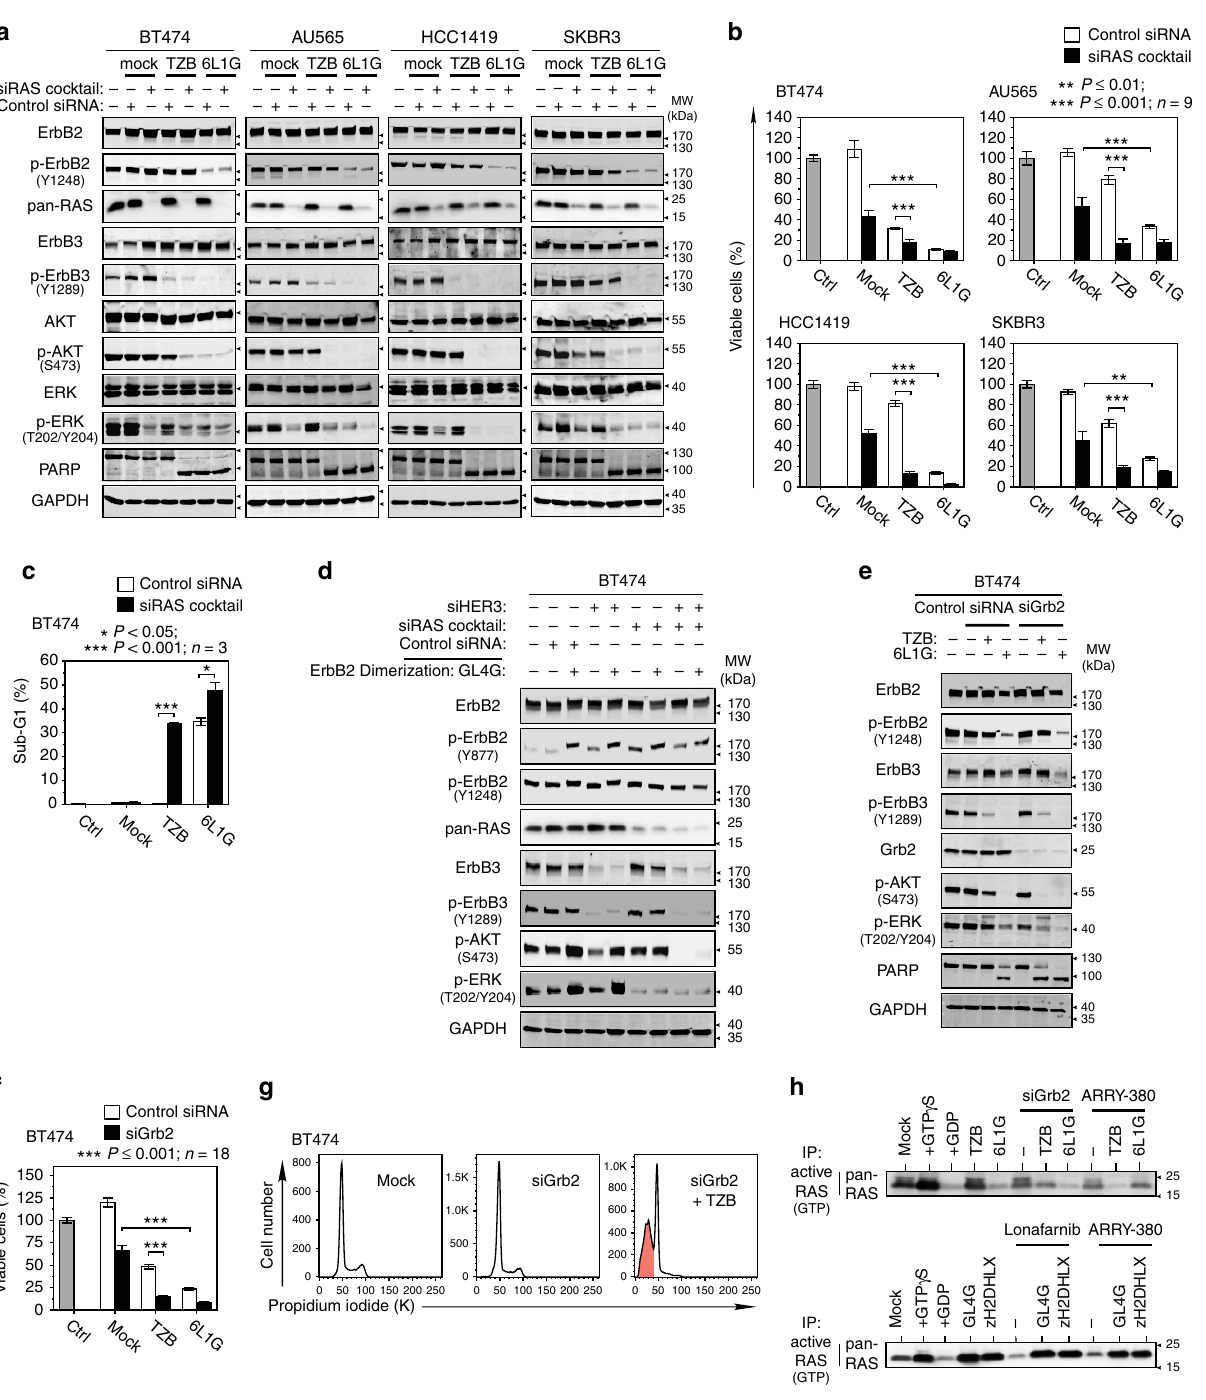
Figure 9 | ErbB2 homodimers stimulate RAS-mediated AKT reactivation. ( a – c ) HRAS/KRAS knockdown in combination with TZB was sufficient to abolish the p-AKT rebound ( a ), to block proliferation ( b ) and to induce apoptosis ( c ) cf . (Supplementary Fig. 5E–H). Analysis was done 72h after knockdown of HRAS/KRAS by siRNA cocktail in combination with 100nM of TZB or 6L1G ( a – c ). Note that HRAS/KRAS knockdown robustly blocks p-ERK in the presence of an active ErbB3/PI3K/AKTpathway ( cf . Supplementary Fig. 5G) (* P value in b Mann–Whitney test; data in c are mean ± s.e.m.,* P value in c two-sided, unpaired Student’s t -test). ( d ) ErbB2 homodimers depend on HRAS/KRAS expression to mediate the p-AKTrebound in the absence of ErbB3 expression. Double knockdown of ErbB3 and RAS results in effective p-AKTand p-ERK inhibition and blocks GL4G-induced p-AKTand p-ERK stimulation completely after 72h of treatment. ( e – g ) Grb2 knockdown in combination with TZB-induced apoptosis by inhibition of the p-AKT rebound. BT474 cells were treated for 72h with 100nM TZB or 6L1G in combination with Grb2 knockdown by siRNA. Immunoblot detection ( e ), XTTcell proliferation assays ( f ) and cell cycle ( g ) (* P value in e Mann–Whitney test). ( h ) Detection of RAS-GTP by pull-down assay with GST-RBD. BT474 cells were treated for 72h with 100nM TZB or 6L1G in combination with siGrb2 knockdown or 12.5 m M ARRY-380 (top), or 50nM GL4G or zH2-DHLX in combination with either 5 m M lonafarnib or 12.5 m M ARRY-380 (bottom).